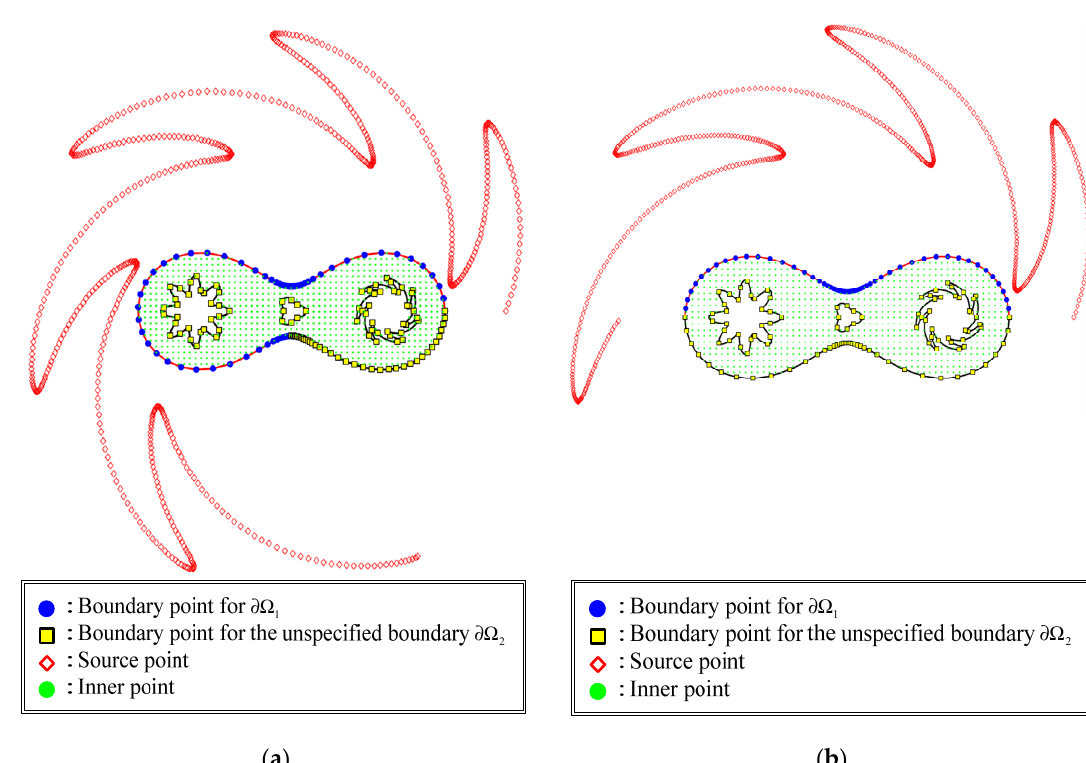
Figure 12. Location of the collocation points for Example 2: ( a ) case A and ( b ) case B. Two scenarios with different accessible boundaries are investigated. The locations of the collocation points for cases A and B are depicted in Figure 12a,b, respectively. The error of the proposed method with different terms of the PPs is investigated, as shown in Figure 13a. Highly accurate results are obtained while the terms are greater than 4. The RMSE is in the order of 10 − 10 if the terms of the PPs range between 5 and 20. Consequently, the terms of the PPs are set as 11 in this example. Figure 13b illustrates the error versus the dilation parameter for case B. Accurate results are obtained for the dilation parameter from 2 to 5.